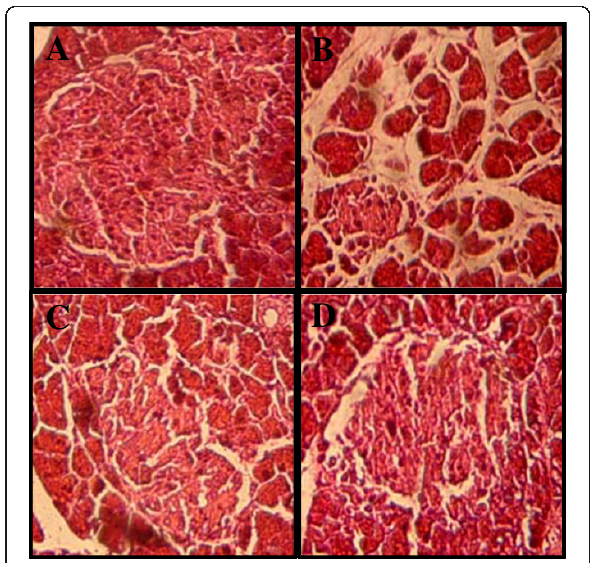
Figure 1 Effect of KT and BT on the histological changes of the pancreas of the rats evaluated by haematoxylin and eosin (H&E) staining (100×). ( A ) Normal control rats (Con) showed normal β cells. ( B ) Severe injury in the β -Cells of the pancreas of diabetic control rats (Diab). ( C ) and ( D ) ameliorative action of KT and BT on the architecture of the pancreas of diabetic rats treated with BT and KT,